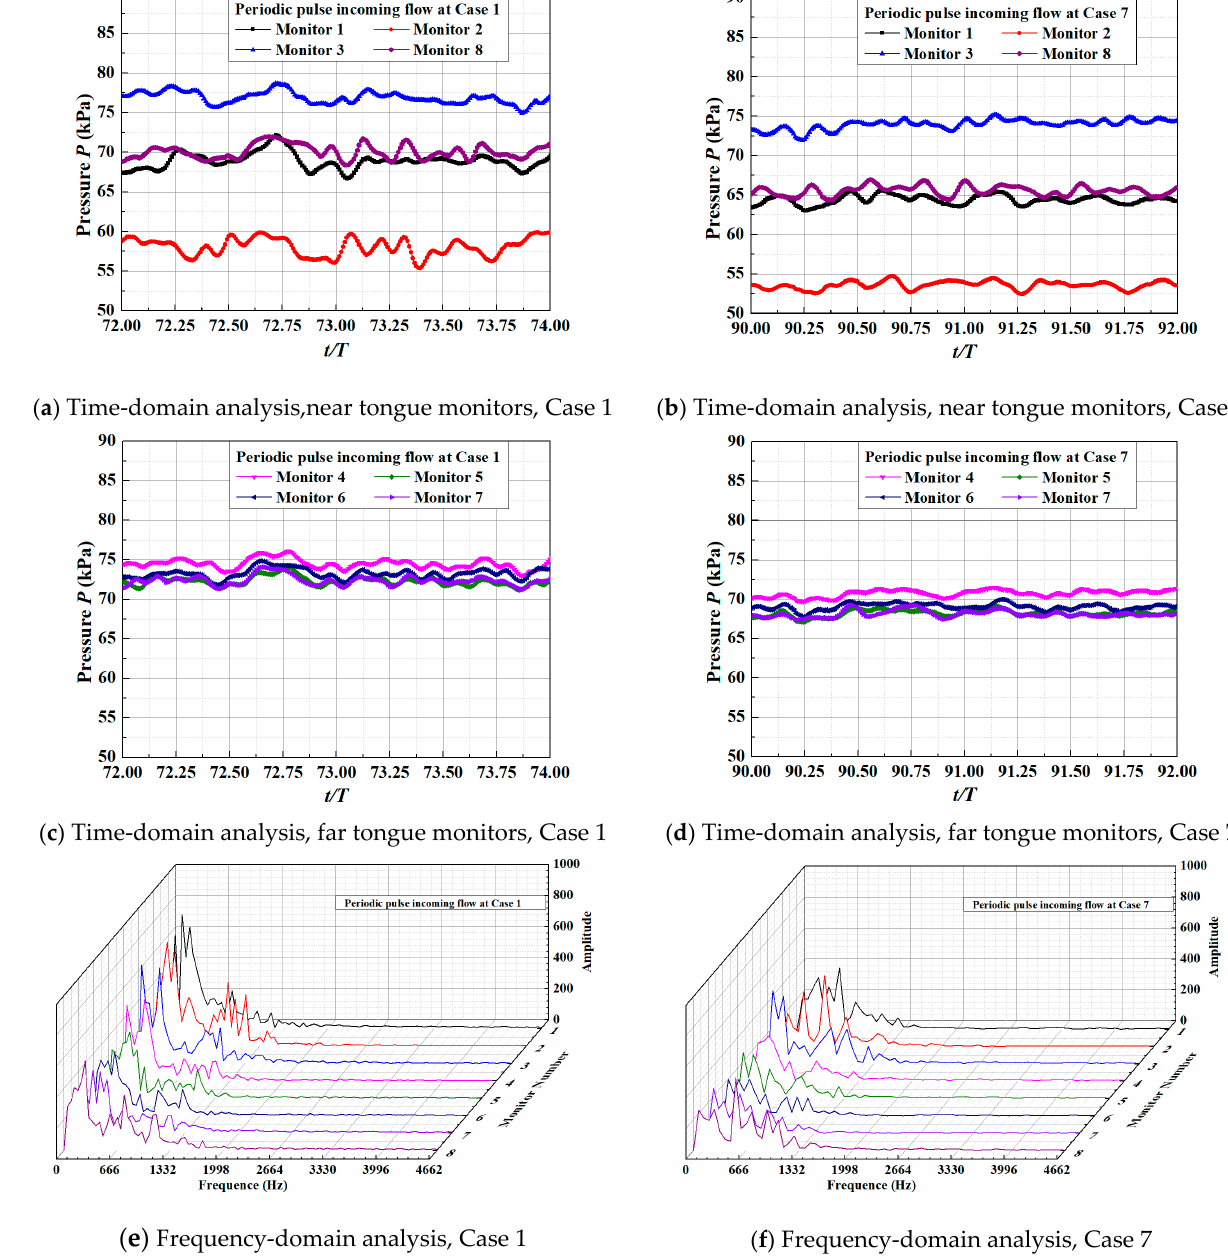
Figure 19. Time-domain and frequency-domain analysis of pressure pulsation for Case 1 (first column) and Case 7 (second column).